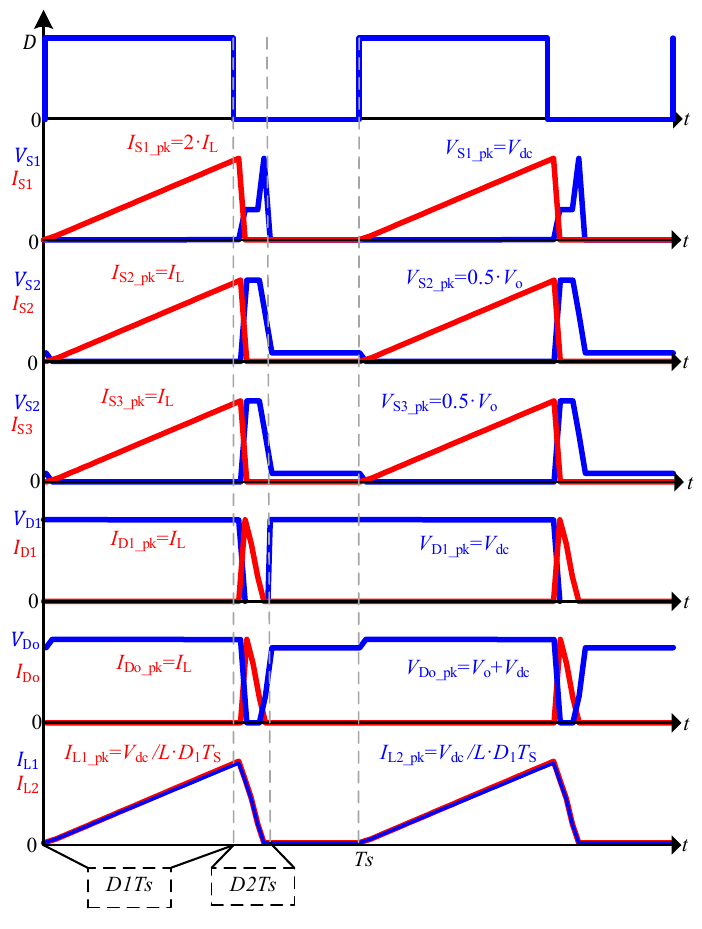
Figure 4. Typical converter waveforms in DCM.